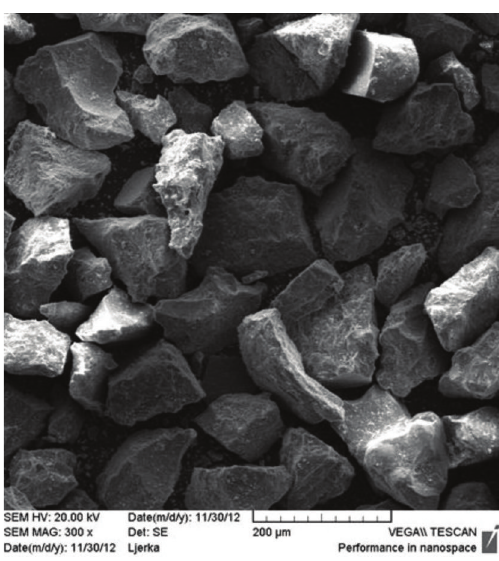
Figure 4: The SEM morphology of the LF slag